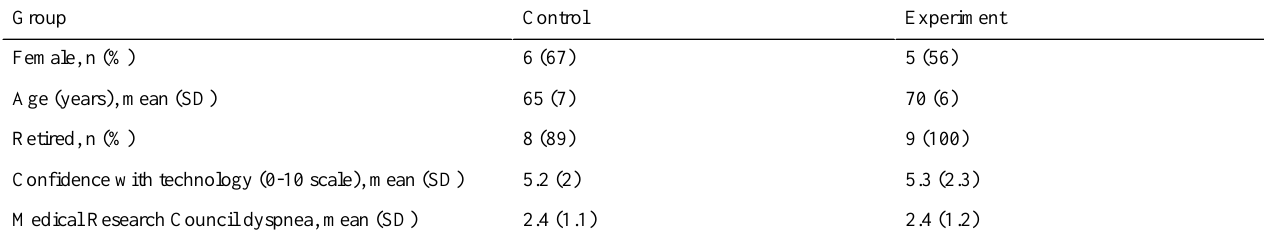
Table 1. Details of participants who received the full intervention in each arm of the study (n=9).